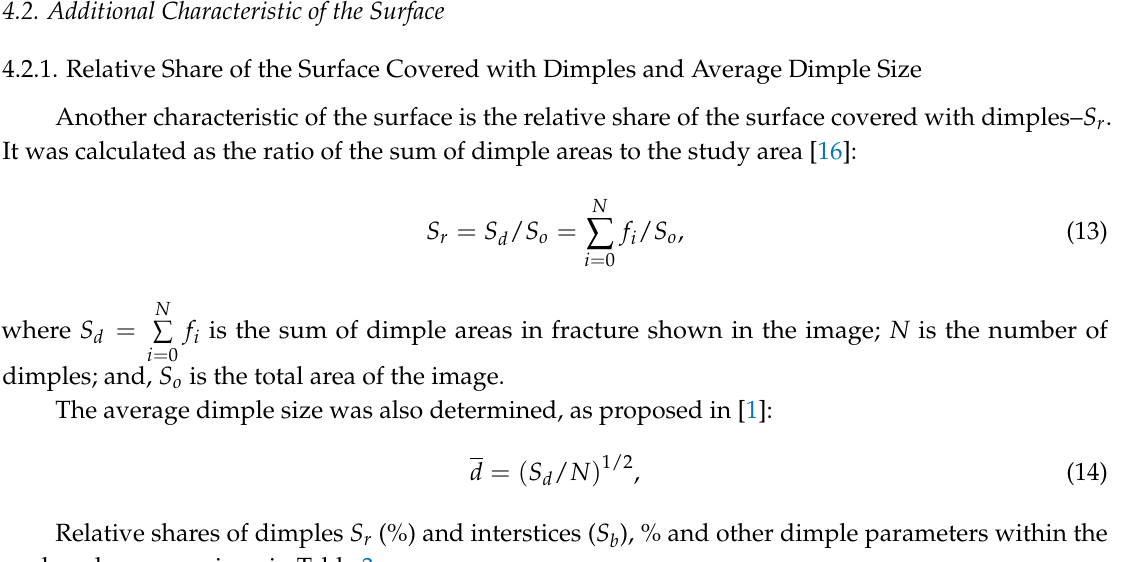
Figure 5. Histogram of the number of dimples with different levels of relative depth t r VT23 ( а ) and VT23M ( b – d ) under static ( а , b ) and impact ( с , d ) loading.